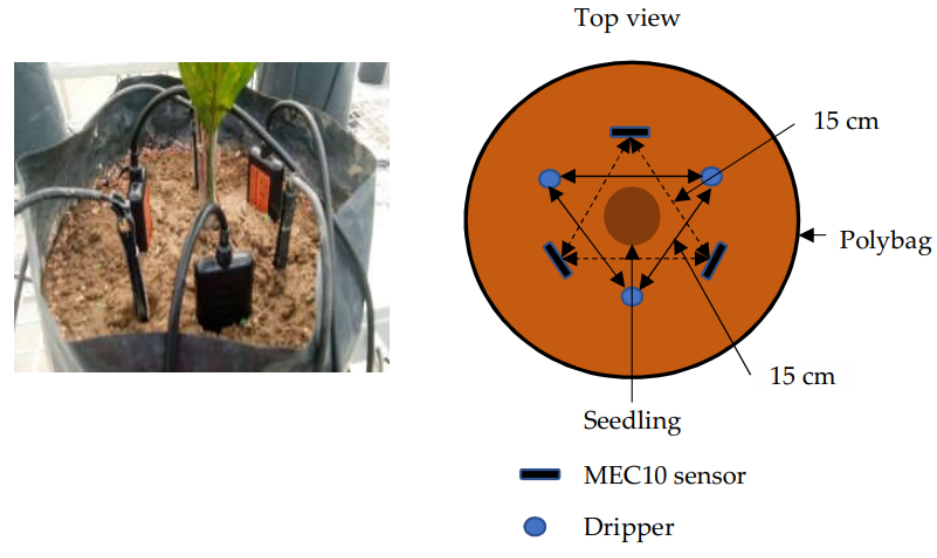
Figure 2. Position of drippers and MEC10 sensors.